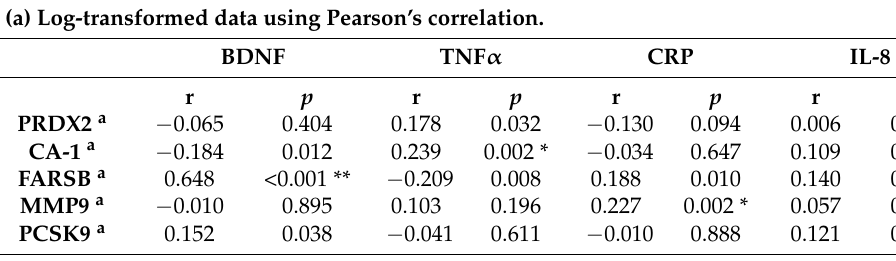
Table 3. Correlation between level of protein levels and cytokine and BDNF in the controls. (a) Log-transformed data using Pearson’s